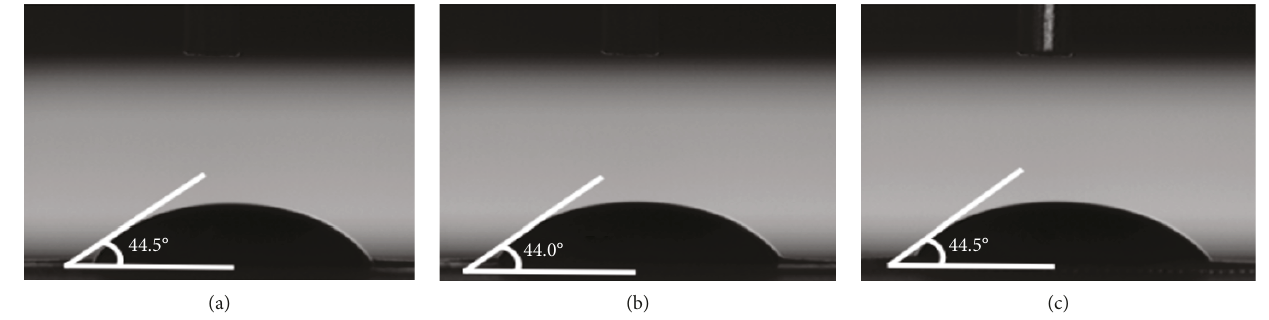
Figure 12: Water contact angle of di ff erent inks ((a) commercial 1; (b) commercial 2; (c) CGCe ink).